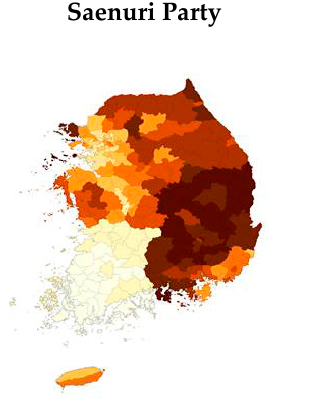
Figure 3. Regional Distribution of Voting Shares for the Saenuri, Democratic, and People’s Parties in Korea’s General Election of 2016.